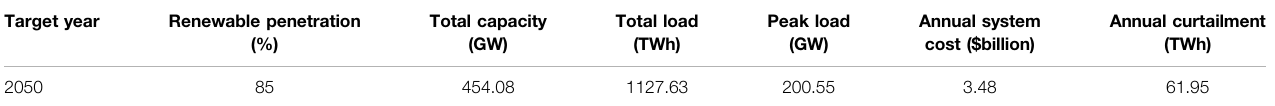
TABLE 1 | Comparison of annual renewable penetration, load, system cost, and curtailment of the 2050 western interconnection system. Target year